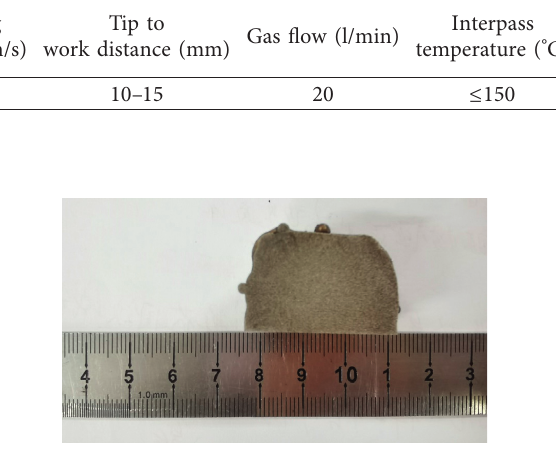
Figure 4: Photograph showing a cross section of the steel sample prepared by